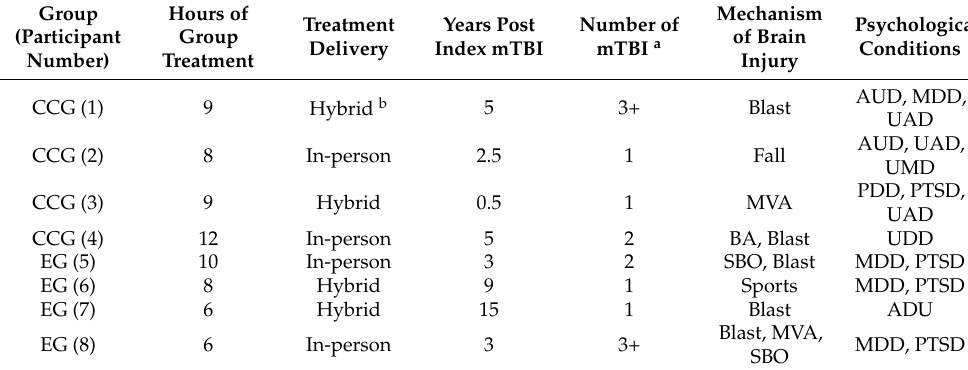
Table 4. Participant Injury and Treatment